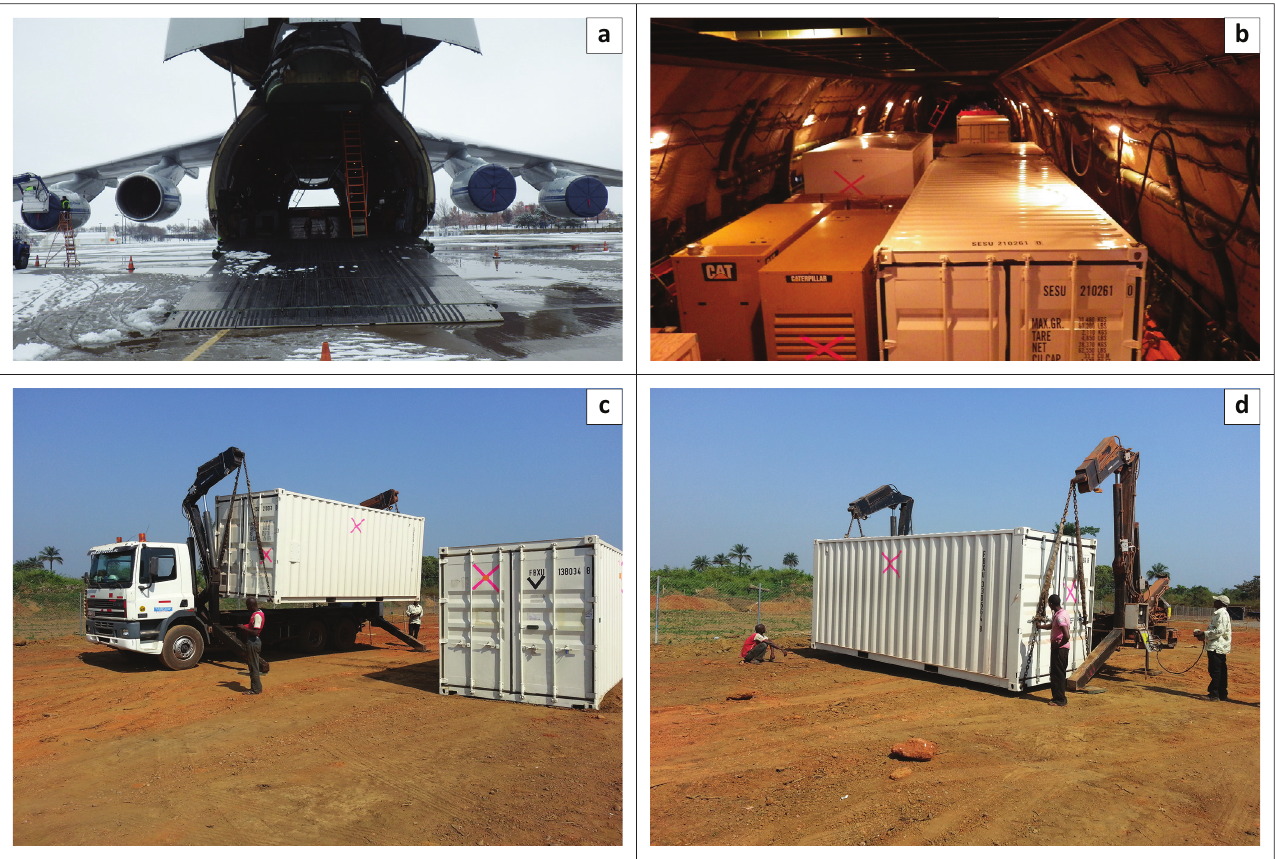
Source : Photos were taken by Scott Poynter in December 2015 and used with permission MDL, mobile diagnostic laboratory. FIGURE 2: Transport of MRIGlobal MDL from the United States to Guinea and Sierra Leone. (a) Antonov An-124 aircraft used to transport the MRIGlobal MDL from Kansas City, Missouri, United States, to Guinea and Sierra Leone sites. (b) Interior of Antonov An-124 aircraft, loaded with MDL units. (c) Truck unloading MDL units in Moyamba, Sierra Leone. (d) Hydraulic system used to unload MDL units in Moyamba, Sierra